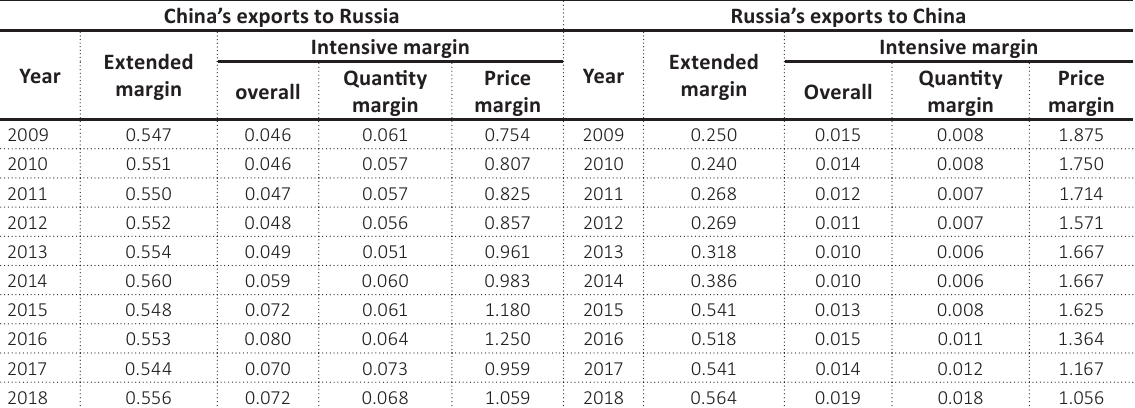
Table 1. The export expansion margins of China and Russia from 2009 to